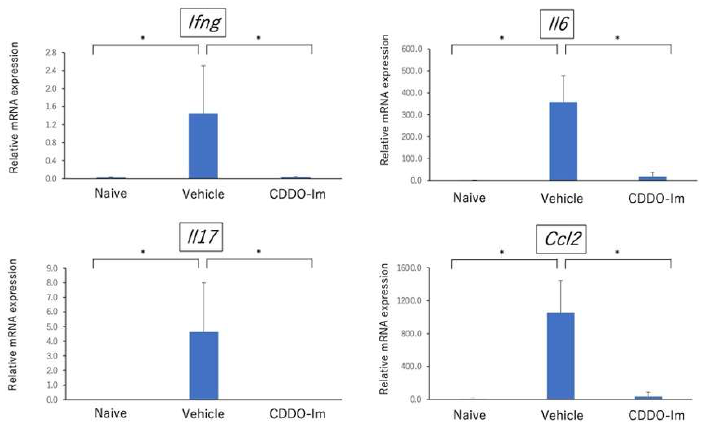
Figure 8. Quantitative PCR analysis of the gene expression of cytokines including Ifng, Il6, Il17, and Ccl2 in retina in naïve mice (non-immunization), vehicle-treated mice and CDDO-Im-treated mice. Mice were immunized with IRBP peptide and vehicle or CDDO-Im was administered on days 0, 2, 4, 6, 8, 10, 12, and 14 after immunization, and eyes were enucleated on day 21. The expression of Ifng, Il6, Il17, and Ccl2 in retina was examined by quantitative PCR. The mean ± standard deviation for each group ( n = 5 mice per group) is shown. Asterisk indicates p < 0.05 versus vehicle-treated mice. Statistical analysis was performed according to ANOVA followed by Bonferroni